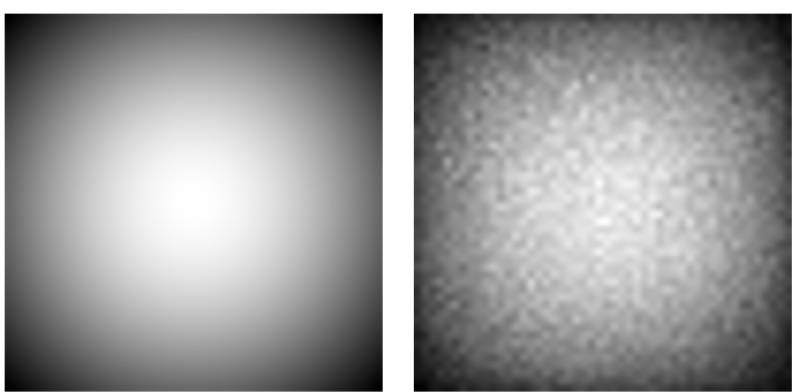
P ^ D ð r ; r Þ , to all other pixels in a regular grid. Right: The average weight sum s k i r i